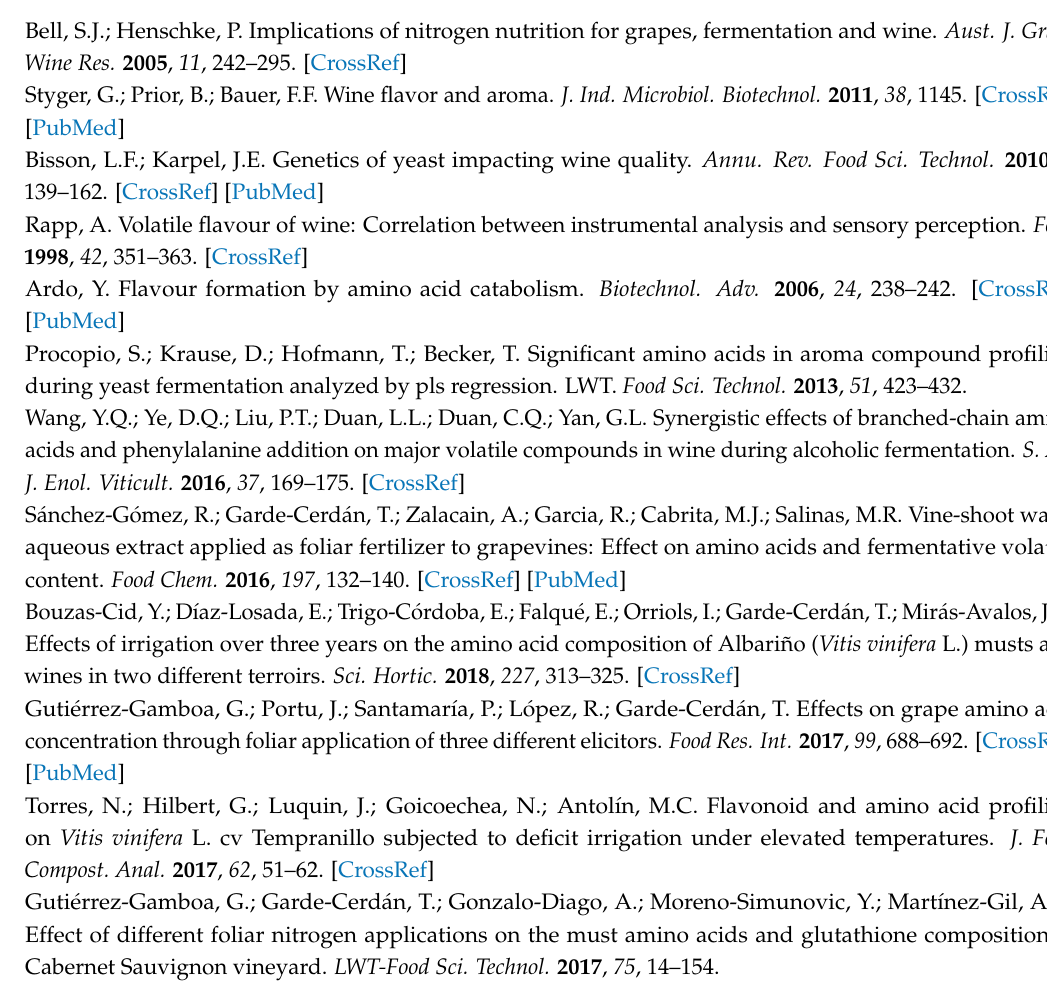
Supplementary Materials: The following are available online: Figure S1–S2, Table